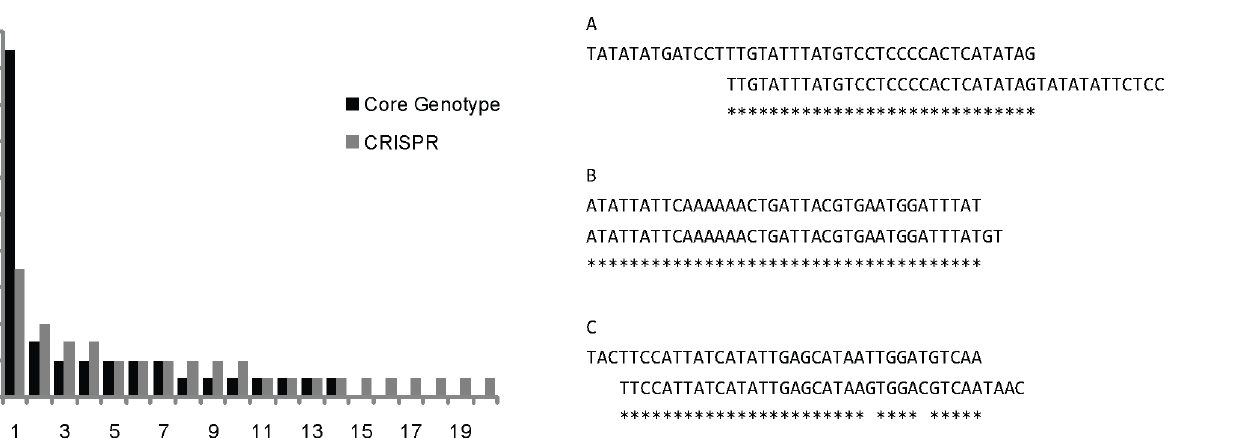
Figure 4. Examples of signatures of independent spacer acquisitions. (A) Spacer pair number 5 from Table S1 shows an example of an offset match with no single nucleotide polymorphisms (SNPs). (B) Spacer pair number 18 from Table S1 shows an example of a match of different length spacers. (C) Spacer pair number 31 from Table S1 shows an example of an offset spacer match with two SNPs. * indicates a shared base between the two spacers. All matches are listed in Table S1.